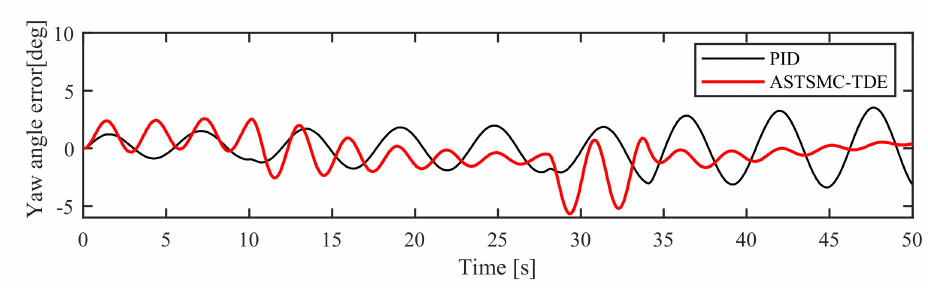
Figure 7. The yaw angle errors.